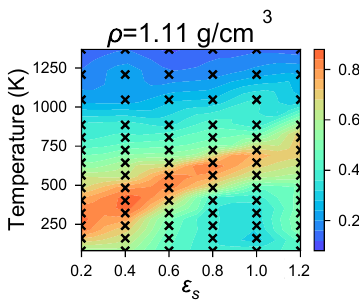
Figure 4. Morphologies sampled with Protocol (2) are observed to have higher ordering, ψ than Protocol (1) at the same state-points (compare Figure 3d), which suggests that simulating solvent evaporation helps to avoid long relaxation